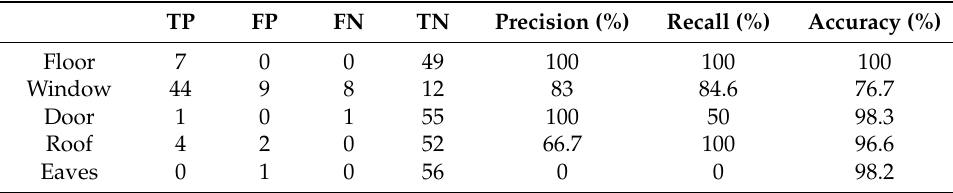
Table 7. Evaluation of semantic recognition for case study 2.